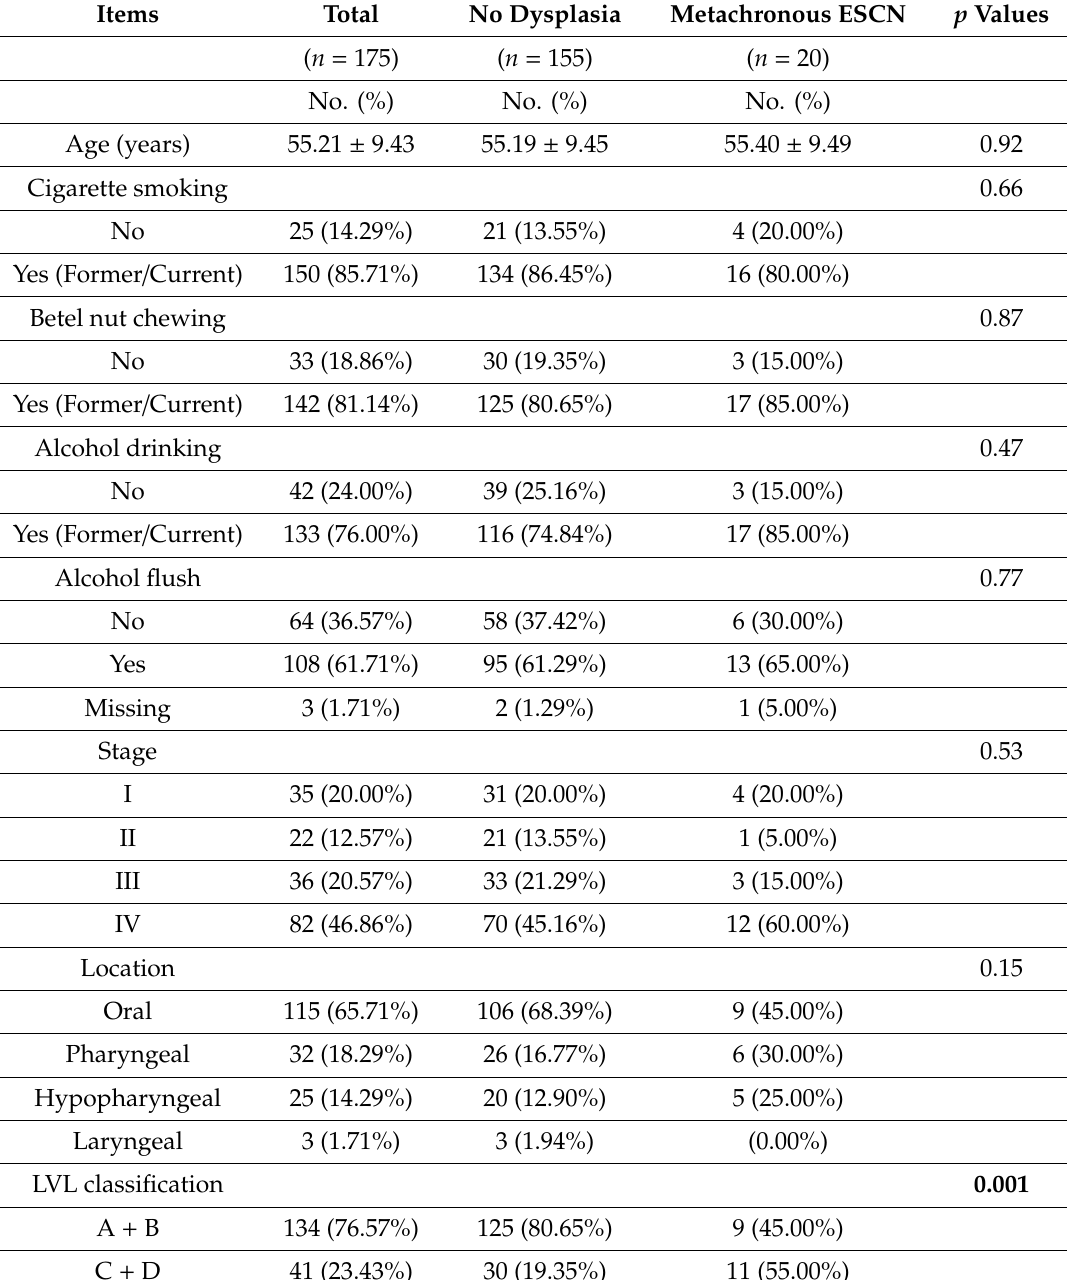
Table 1. Characteristics of 175 patients with